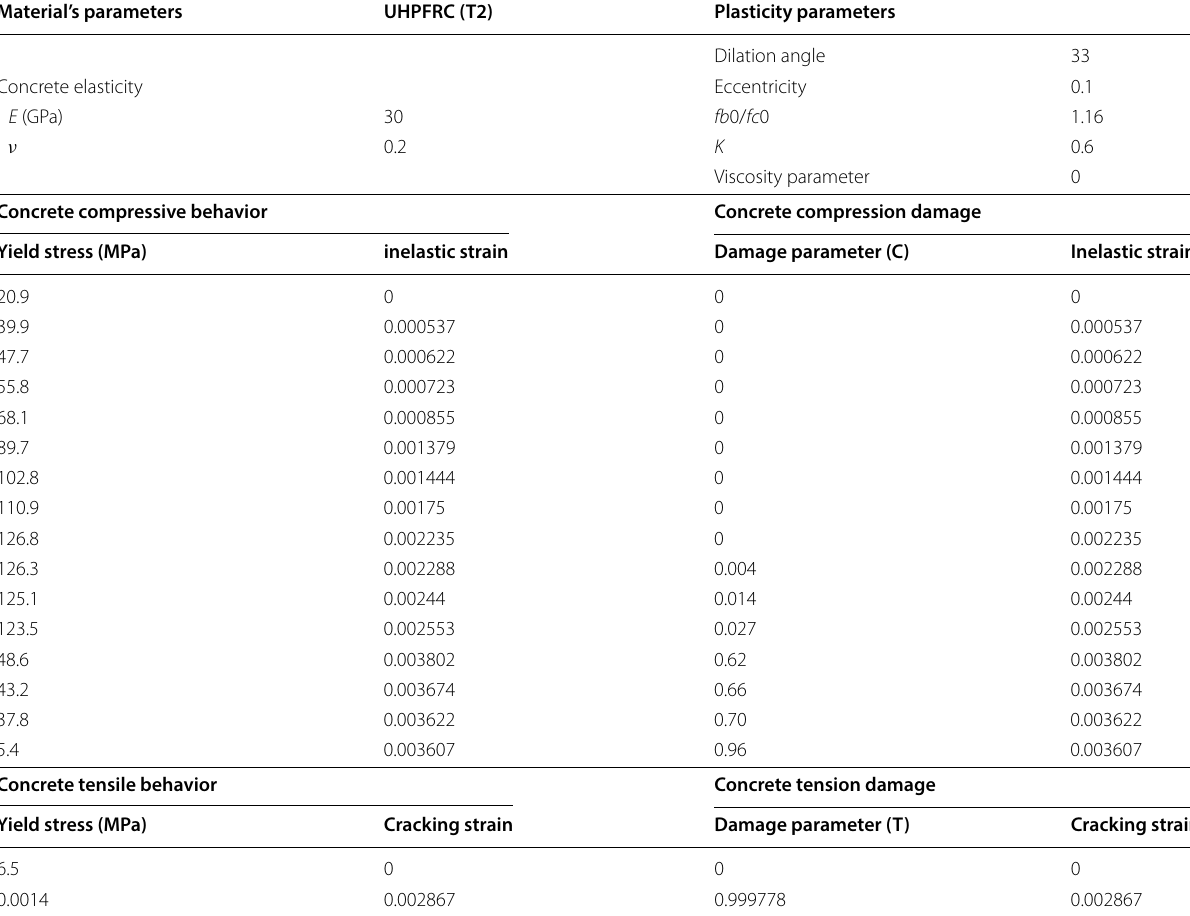
Table 8 Material properties for concrete with developed constitutive model in UHPFRC with Forta-Ferro synthetic fibers